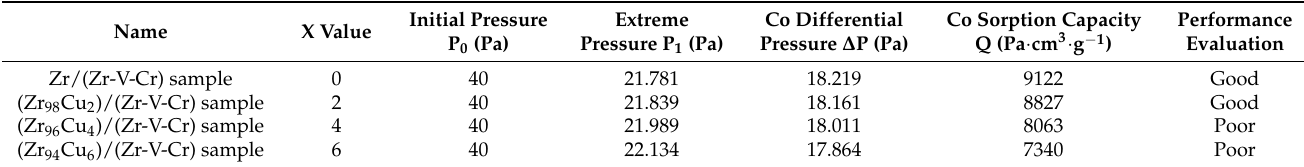
Table 2. CO sorption capacity parameters of coated samples.